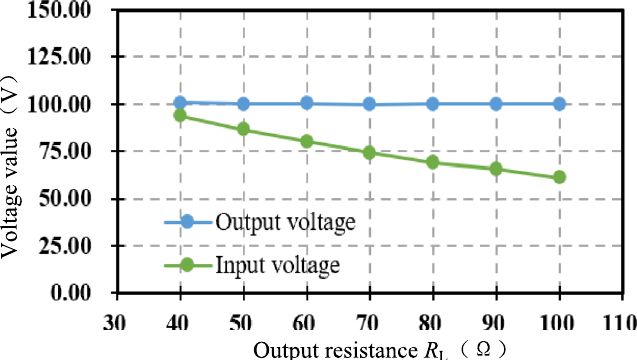
Figure 23. Output voltage and adjustable input voltage under compound